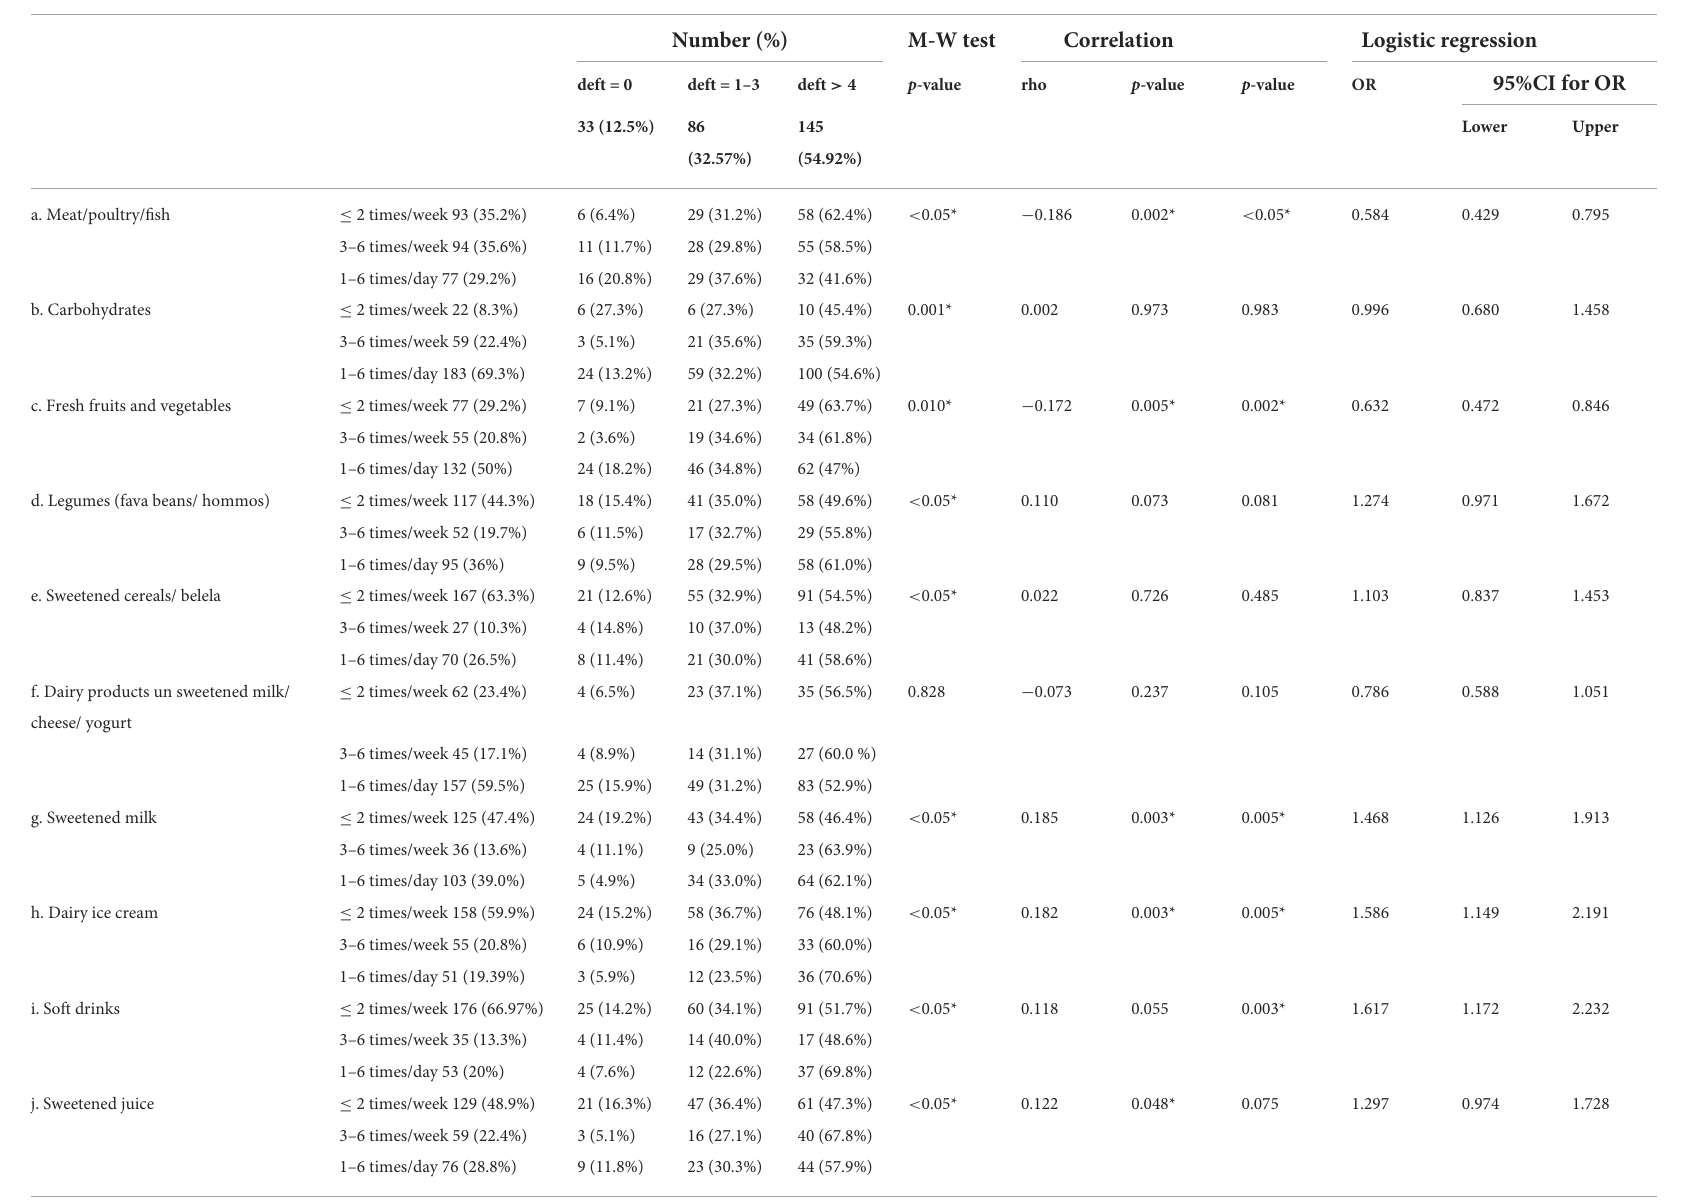
TABLE 7 Correlation between deft index and frequency of intake of different food items (Total number